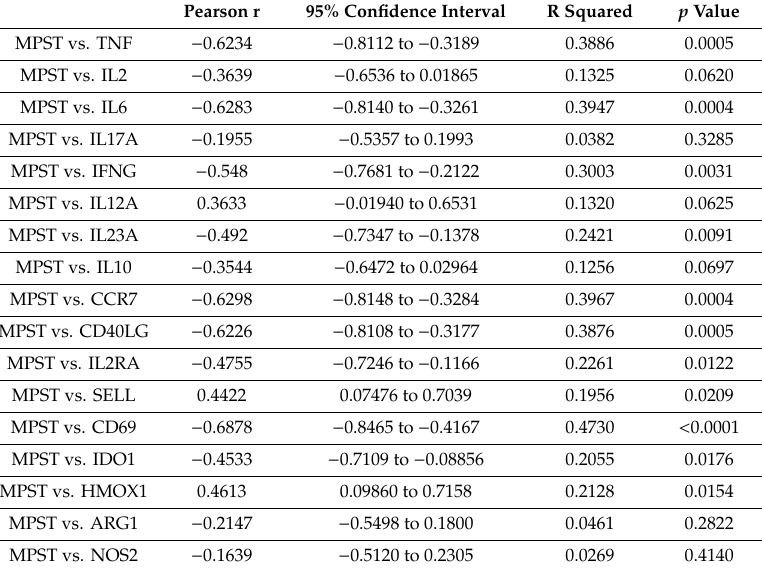
Table 1. Correlation between the MPST expression and the markers of immune activation as determined in the GSE138064